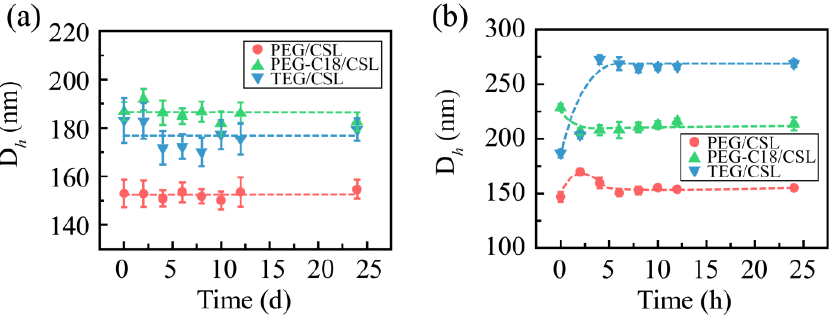
Figure 4. Particle sizes of CSL nanoparticles in 5% glucose solution ( a ) and plasma ( b ) after 24 h of incubation, n = 3.